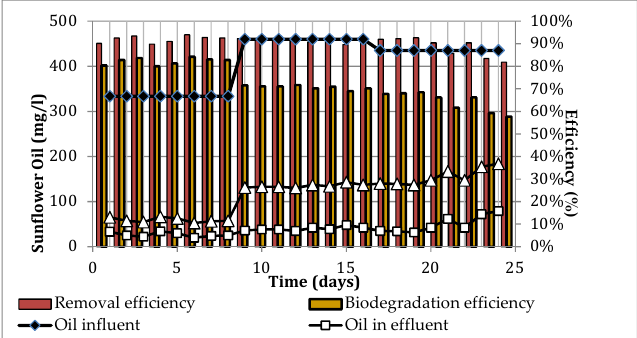
Figure 5. Changes in removal and biodegradation e ffi ciencies of sunflower oil for the bench-scale activated sludge reactor.